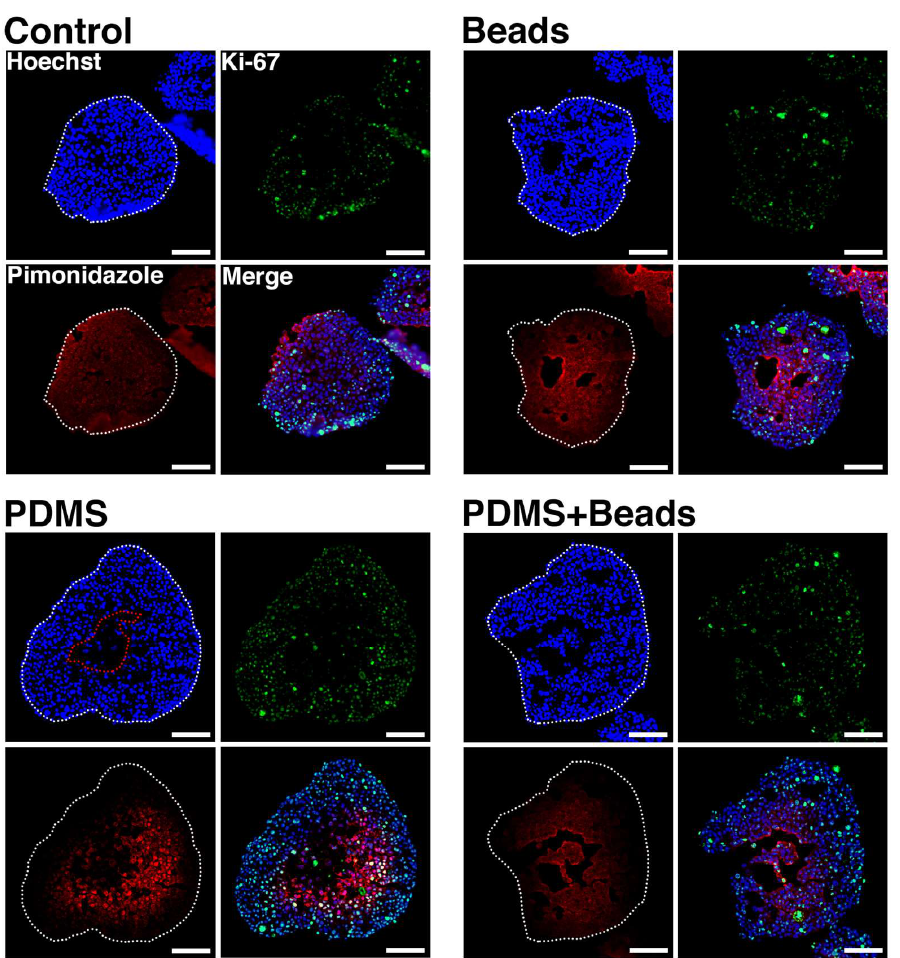
Figure 5. Nuclear, Ki-67 and pimonidazole visualization within spheroids. Frozen sections from spheroids at day 1 were stained with Hoechst (blue), anti-Ki-67 antibody (green), and anti-pimonidazole antibody (red). White broken lines indicate the outlines of the spheroids. Scale bars: 100 µm.